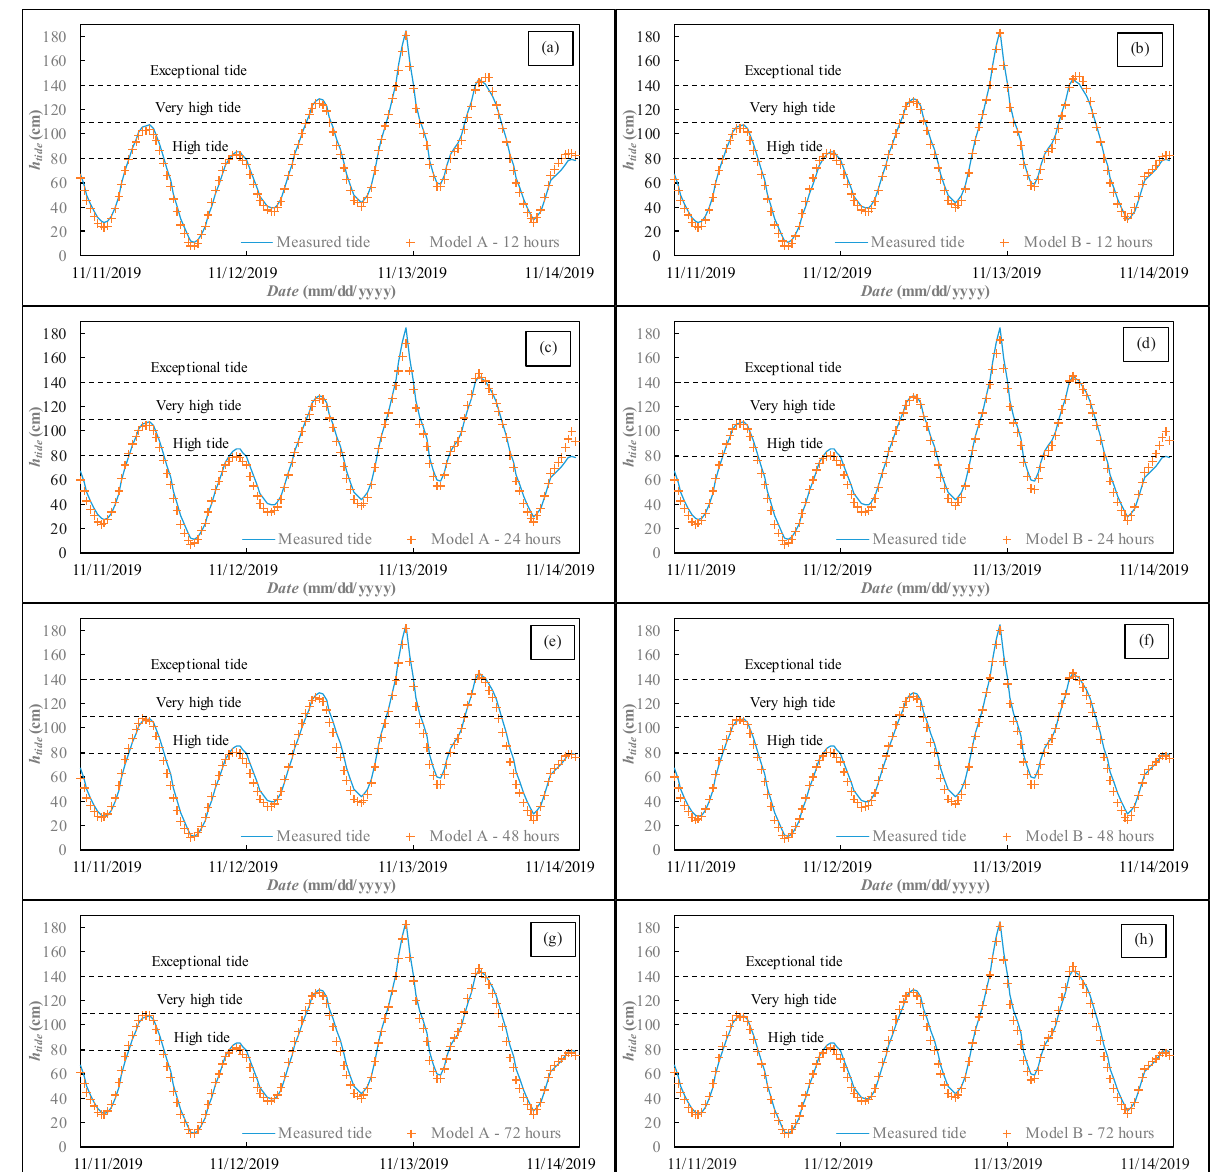
Figure 4. Extreme storm tide events forecasting in the period 11–14 November 2019, comparison between measured time series and predicted values: Model A— t a = 12 h ( a ); Model B— t a = 12 h ( b ); Model A— t a = 24 h ( c ); Model B— t a = 24 h ( d ); Model A— t a = 48 h ( e ); Model B— t a = 48 h ( f ); Model A— t a = 72 h ( g ); Model B— t a = 72 h ( h ).